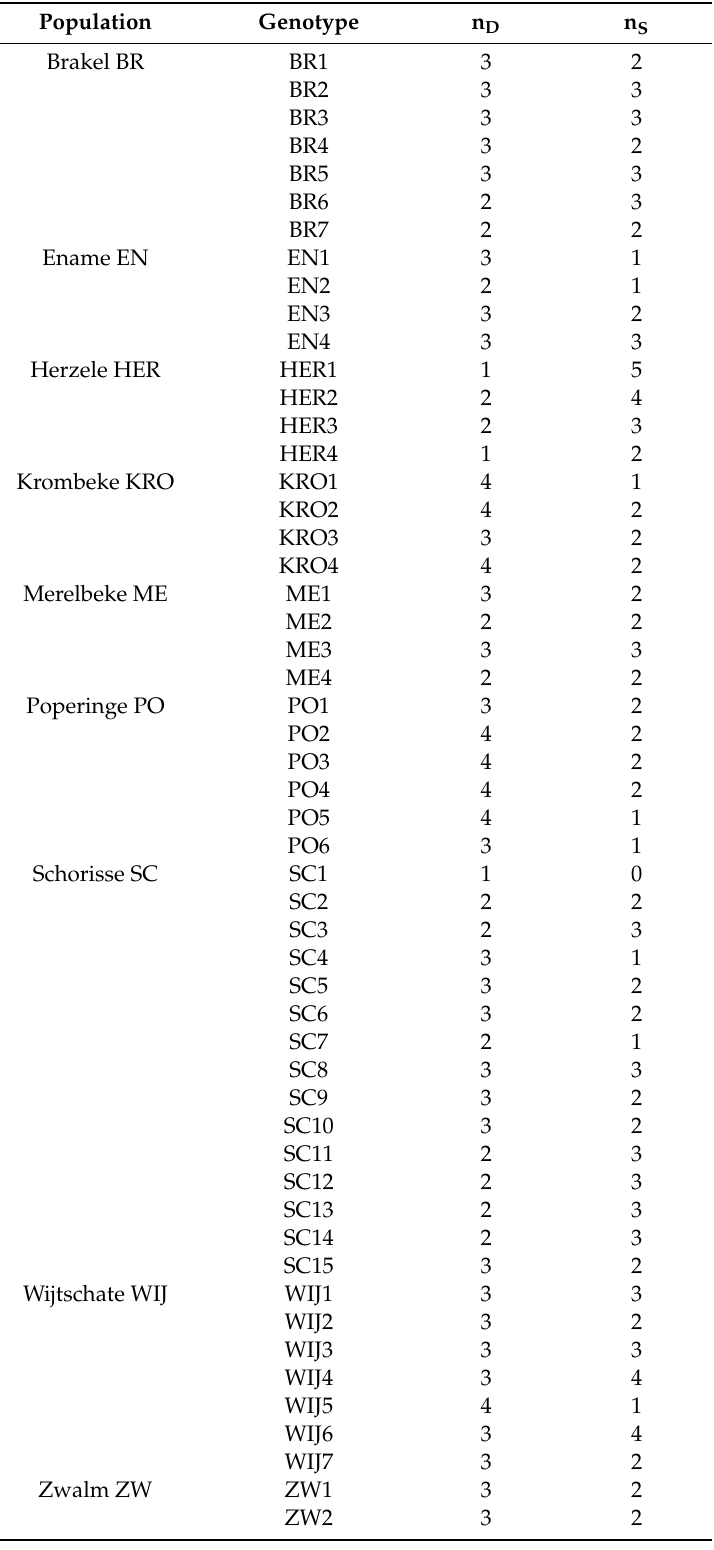
Table 1. Genotypes of Prunus padus L. that were sampled in natural populations in the northern part of Belgium and vegetatively propagated, and the number of ramets that were planted in the two common gardens at Dentergem (n D ) and Semmerzake (n S